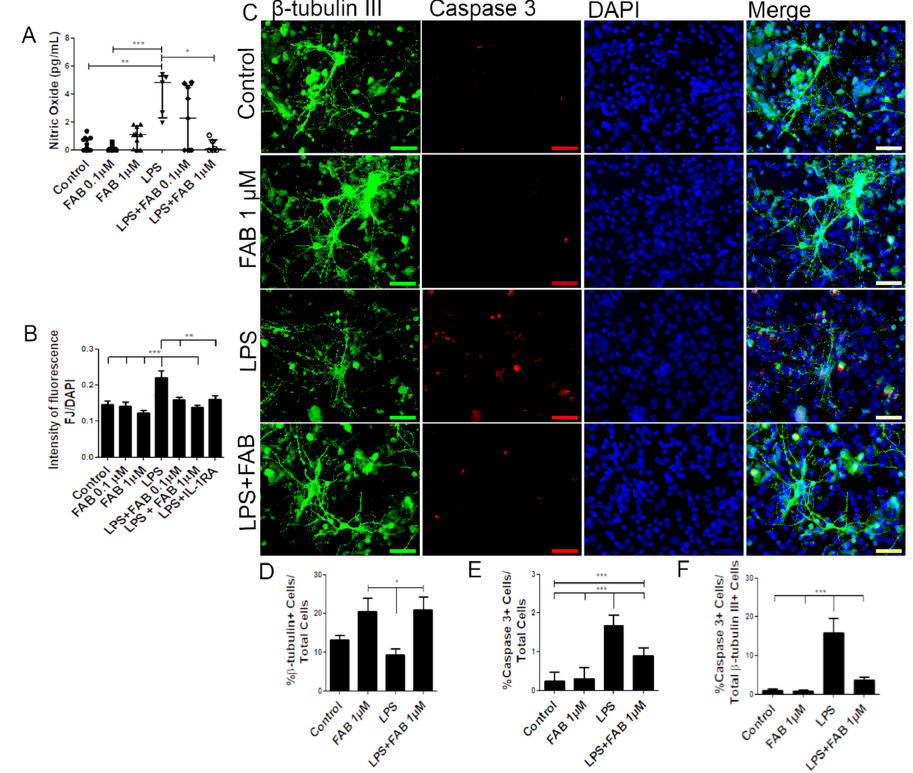
Figure 1. Agathisflavone (FAB) protects neurons against lipopolysaccharide (LPS)-induced neuroinflammatory damage. Cells were incubated with 0.01% of vehicle (dimethyl sulfoxide, DMSO) or treated with 1 µg LPS, 0.1 and/or 1 µM of FAB, or during 24 h of damage by LPS followed by a further 24 h using 0.1 and/or 1 µM of FAB. ( A ) Boxplot graph showing the Griess reaction for NO determination; results are expressed as NaNO 2 ; values are expressed as the median and tested for significance by the Kruskal–Wallis test followed by Dunn’s test. ( B ) Bar graph of the proportion of neurons undergoing degeneration measured by the Fluoro-Jade B (FJ-B) fluorescence intensity/4,6-diamidino-2-phenylindole (DAPI) fluorescence intensity stain; values are expressed as the mean ± SEM ( n = 3) and were tested for significance by one-way ANOVA. ( C ) Representative photomicrographs of immunocytochemistry (ICC) for detection of the apoptotic marker caspase-3 (red), counterstained with the neuronal marker β -Tubulin III+ (green) and nuclei marked with DAPI (blue) by fluorescence microscopy; scale bar: 50 µm. ( D – F ). Bar graphs showing the percentage of β TubIII+, caspase-3 + cells, and β TubIII+/caspase-3 + cells in each condition; values are expressed as the * p < 0.05.